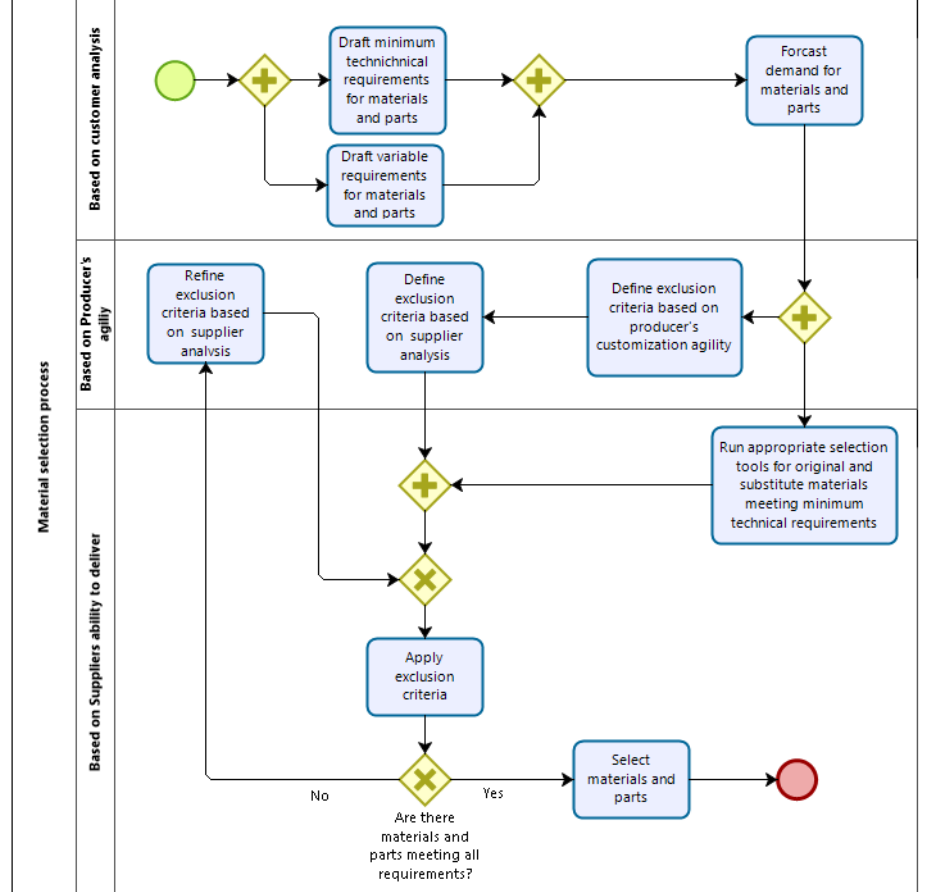
Figure 2. Material selection process.